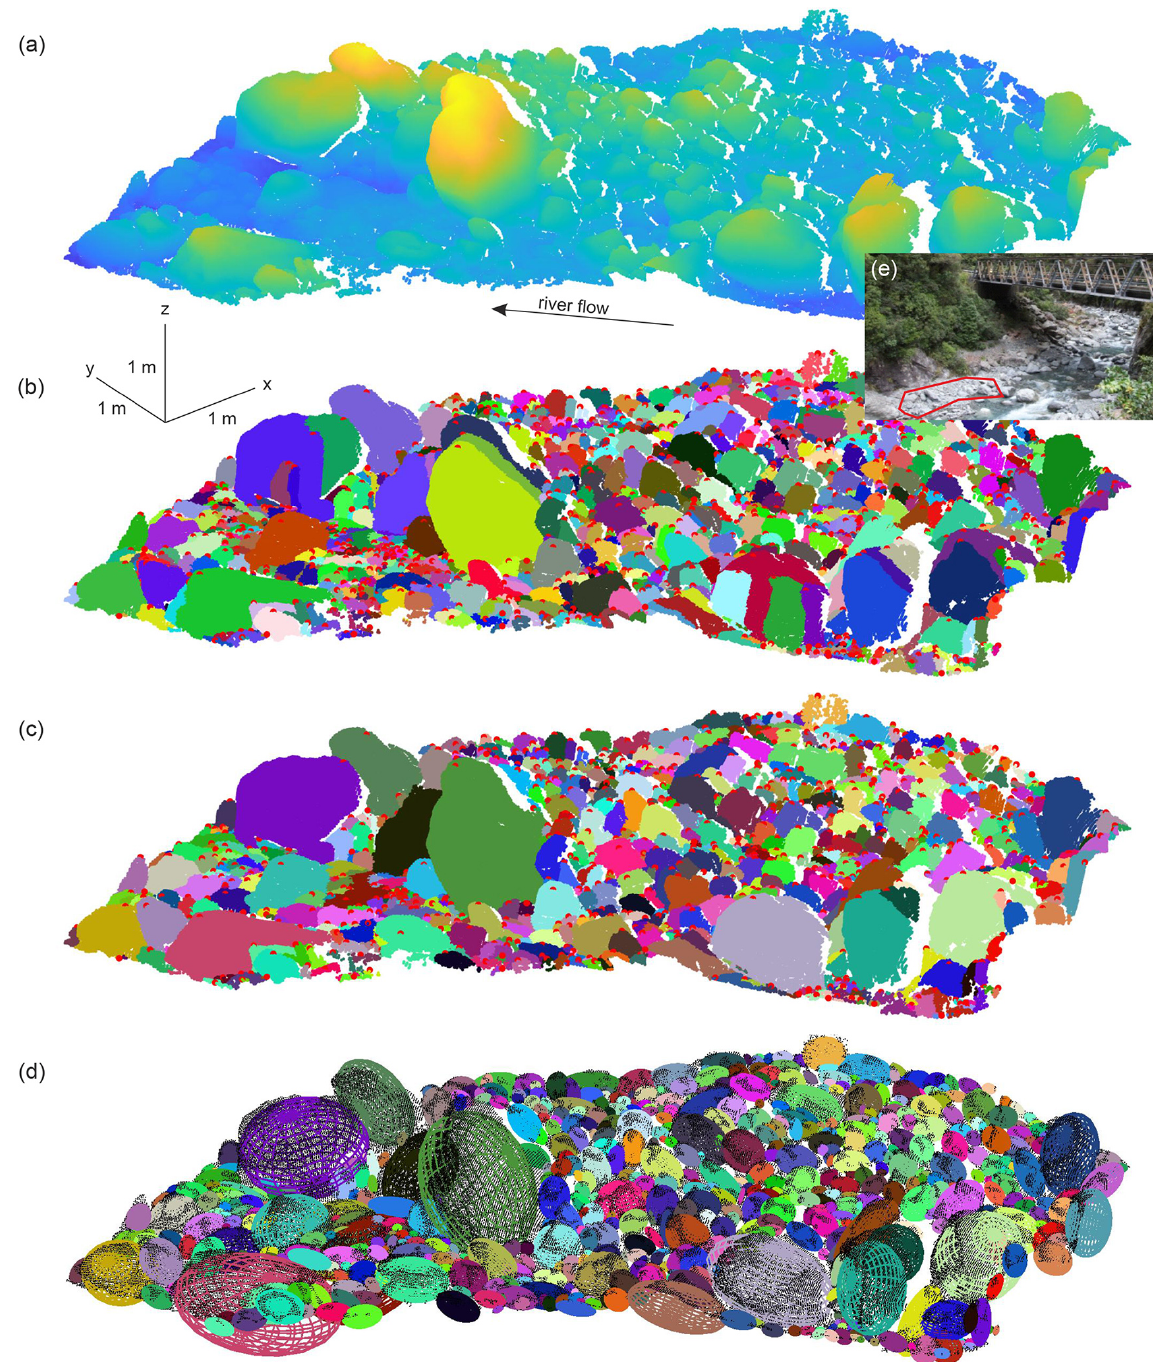
Figure 2. Three-dimensional view of the point cloud, its segmentation into individual grains and the fit ellipsoids. (a) Initial point cloud with the color map indicating the elevation of the points. (b) Initial segmentation of the point cloud into individual grains performed with a modified watershed algorithm using the steepest upward slope criterion to route water. (c) Segmentation after merging close grains together. (d) Ellipsoid fit to each individual grain identified in panel (c) is represented by colored lines (same color as in panel c ) over the point cloud (black dots). Color in panels (a) , (b) and (c) indicates the label of the grains (i.e., one color per grain). Red dots in panels (a) and (b) indicate the location of the summit point of each grain. (e) Picture showing the location of the point cloud surface, bounded by a red polygon, relative to the Otira